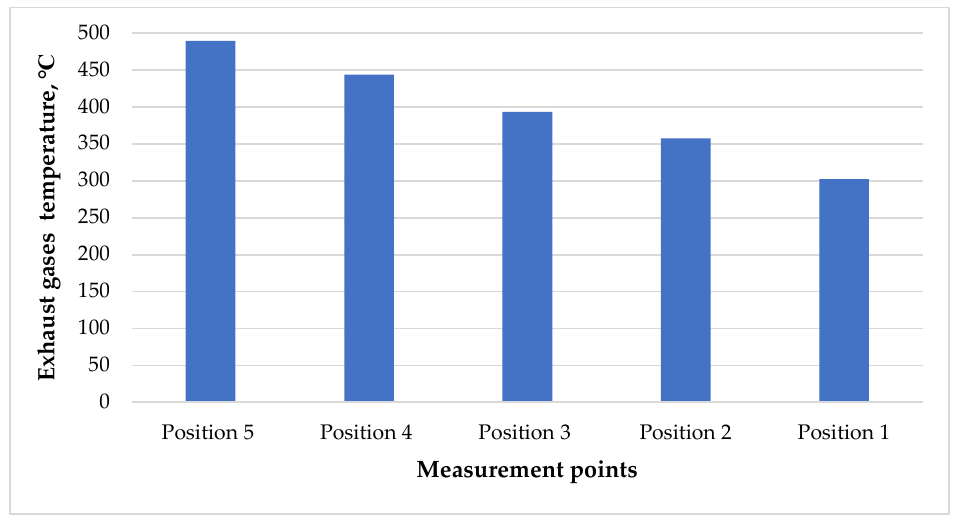
Figure 5. Temperature of the exhaust gases at various measurement points.